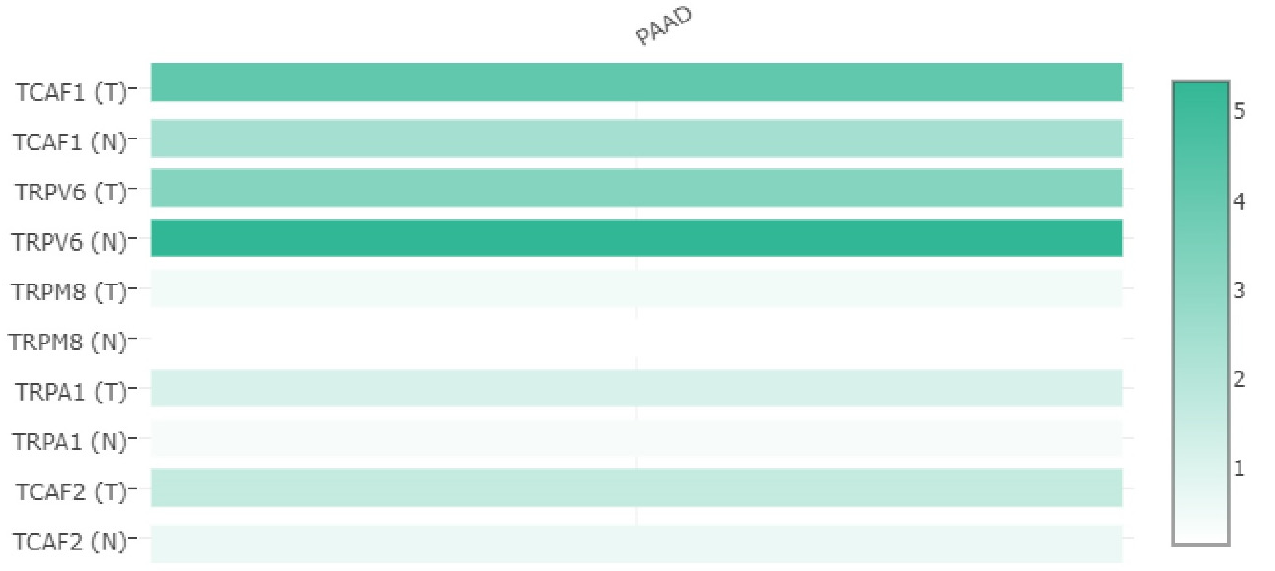
Figure 2. The heatmap of the selected TRP gene profiles obtained with RNA-Seq (GEPIA matrix plot). The expression profiles were obtained after normalization by log2 (TPM + 1). The data represent a comparison of PDAC and normal pancreatic tissues from the “TCGA normal + GTEx normal” database. The color gradient spans from high expression (dark green) to low expression (light green). Log fold changes up to five-fold are illustrated, indicating differential expression with respect to the normal expression for each gene